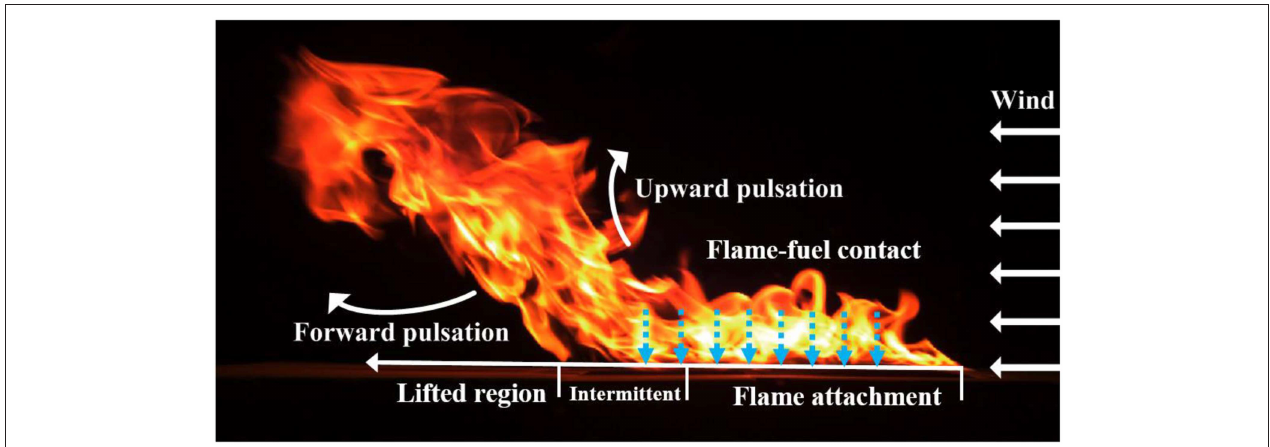
FIGURE 1 | The movement of a stationary, wind-driven flame is depicted here with forward and upward pulsations and flame-fuel contact depicted throughout the attached, intermittent and lifted regions of the flame.